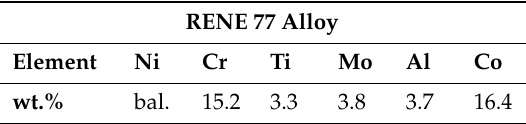
Table 2. Chemical composition of RENE 77 alloy.